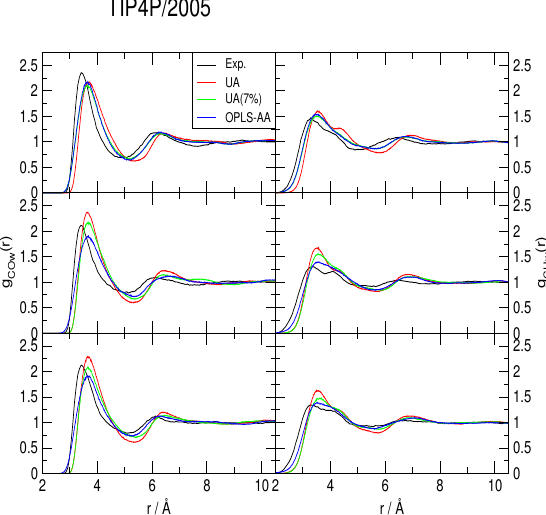
Figure 2. Comparison to the experimentally determined [34] methane-water radial distribution functions of those obtained from simulations with the TIP4P/2005 water model at 277 K ( top ), 283 K ( middle ) and 291 K ( bottom ), all under a pressure of 145 bar. UA: United-atom model from Reference [41]; UA (7%): Same model with a 7% correction for the C − O interaction; OPLS-AA: All-atom force-field from Reference